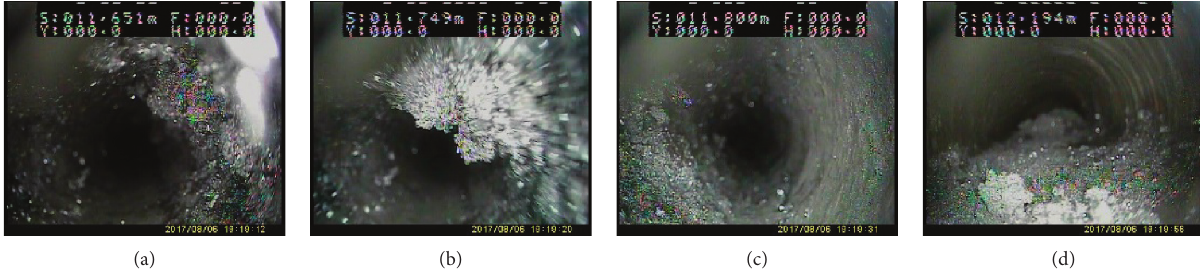
Figure 15: The distribution of the surrounding rock (7.8–10 m) outside the anchor zone. (a) 7.9 m. (b) 8.3m. (c) 9.2m. (d) 10.0m.